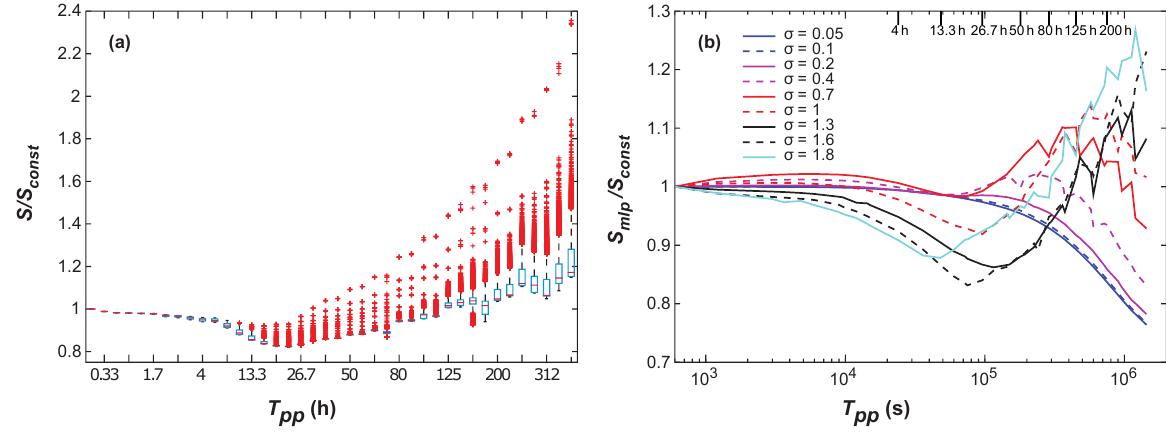
Figure 6. (a) Distribution of the ratios of slope during the last pulse to the constant-feed slope for all 40 runs with σ = 1 . 6. We normalized the values of the slope in the last pulse with the slope of the constant-feed run of the same grain size distribution width ( σ ), allowing for the comparison of the equilibrium slopes between runs with different σ . The red lines represent the normalized mean slopes ( S mlp /S const ), which we chose as the main indicator for the equilibrium state of the channel slope. Note that data from longer pulse periods T pp will contain more data points for the box plots, as there are more slope values recorded during the longer time between pulses (sampling every 10min). The red crosses are outliers in the distribution of slope values, illustrating the extreme slope values during the time right after the pulse was introduced into the channel. (b) Mean slope ratios for all runs grouped by width of GSD ( σ ).